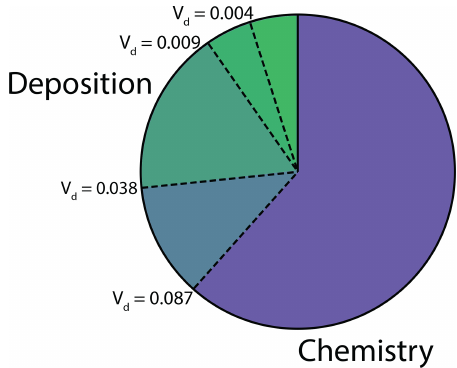
Figure 6. Fraction of NO x loss to deposition and chemistry (nitric acid, alkyl nitrate, and peroxyacyl nitrate) at night (20:00–05:00). The four dashed lines between the deposition and chemistry frac- tions show NO x loss with a nighttime NO 2 deposition velocity of 0.004, 0.009, 0.038, and 0.087cms − 1 . These deposition velocities, respectively, represent the minimum, first quartile, third quartile, and maximum of the median nighttime deposition velocities mea- sured for the native California trees examined in this